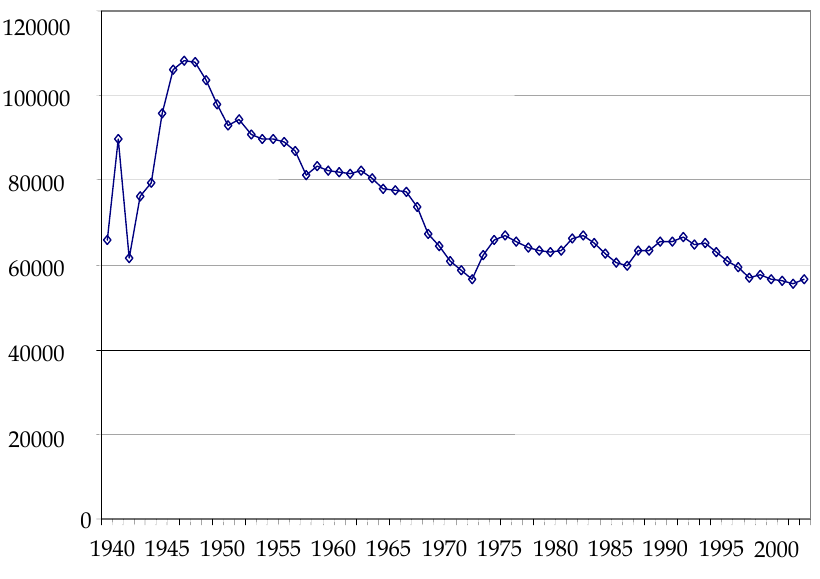
Figure 1 . Number of births in Finland by the year 1940 – 2003